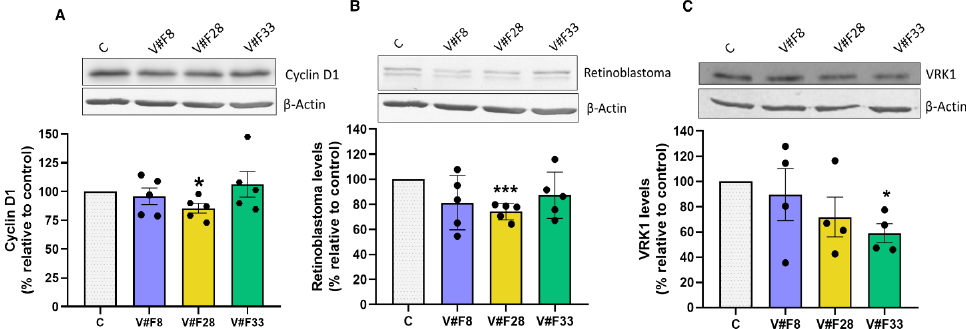
Figure 5. VRK1 aptamers decrease Cyclin D1, Rb and VRK1 protein levels. MCF7 cells were plated at 5 × 10 5 cells/well in p6 plates. After 24 h , aptamers were transfected at 50 nM for 24 h and cell lysates ( 20 μg ), obtained as described in the Materials and Methods Section, were subjected to SDS-PAGE 12% and Western blot analysis using anti-cyclin D1 (A), anti-Rb (B) or anti-VRK1 (C) antibodies. Actin was used as a control for the homogeneity of loading. The quantitation of the bands was normalized with respect to actin and expressed as the percentage relative to the value in control cells. The values represent the mean ± S.E.M. of 4 – 5 different experiments. Representative blots are shown on the top of the figure. Statistical differences relative to 100; * p < 0.05; *** p < 0.001.